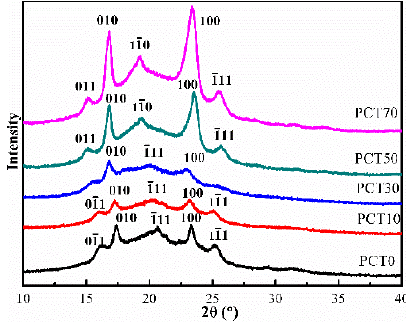
Figure 5. WAXD patterns of the (PBT-co-PCT)-b-PTMG copolymers.